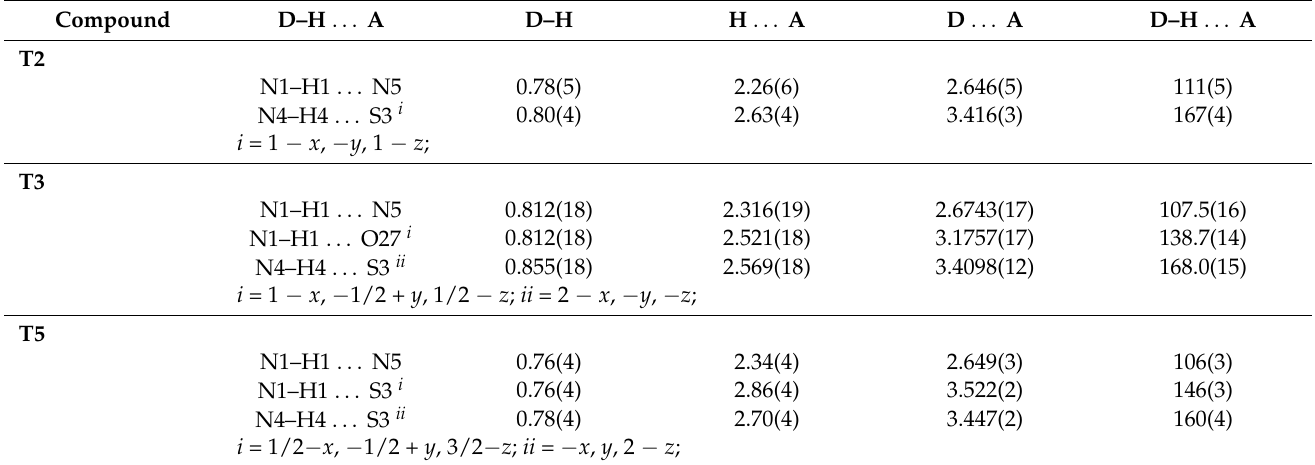
Table 1. Hydrogen-bond geometry (Å, ◦